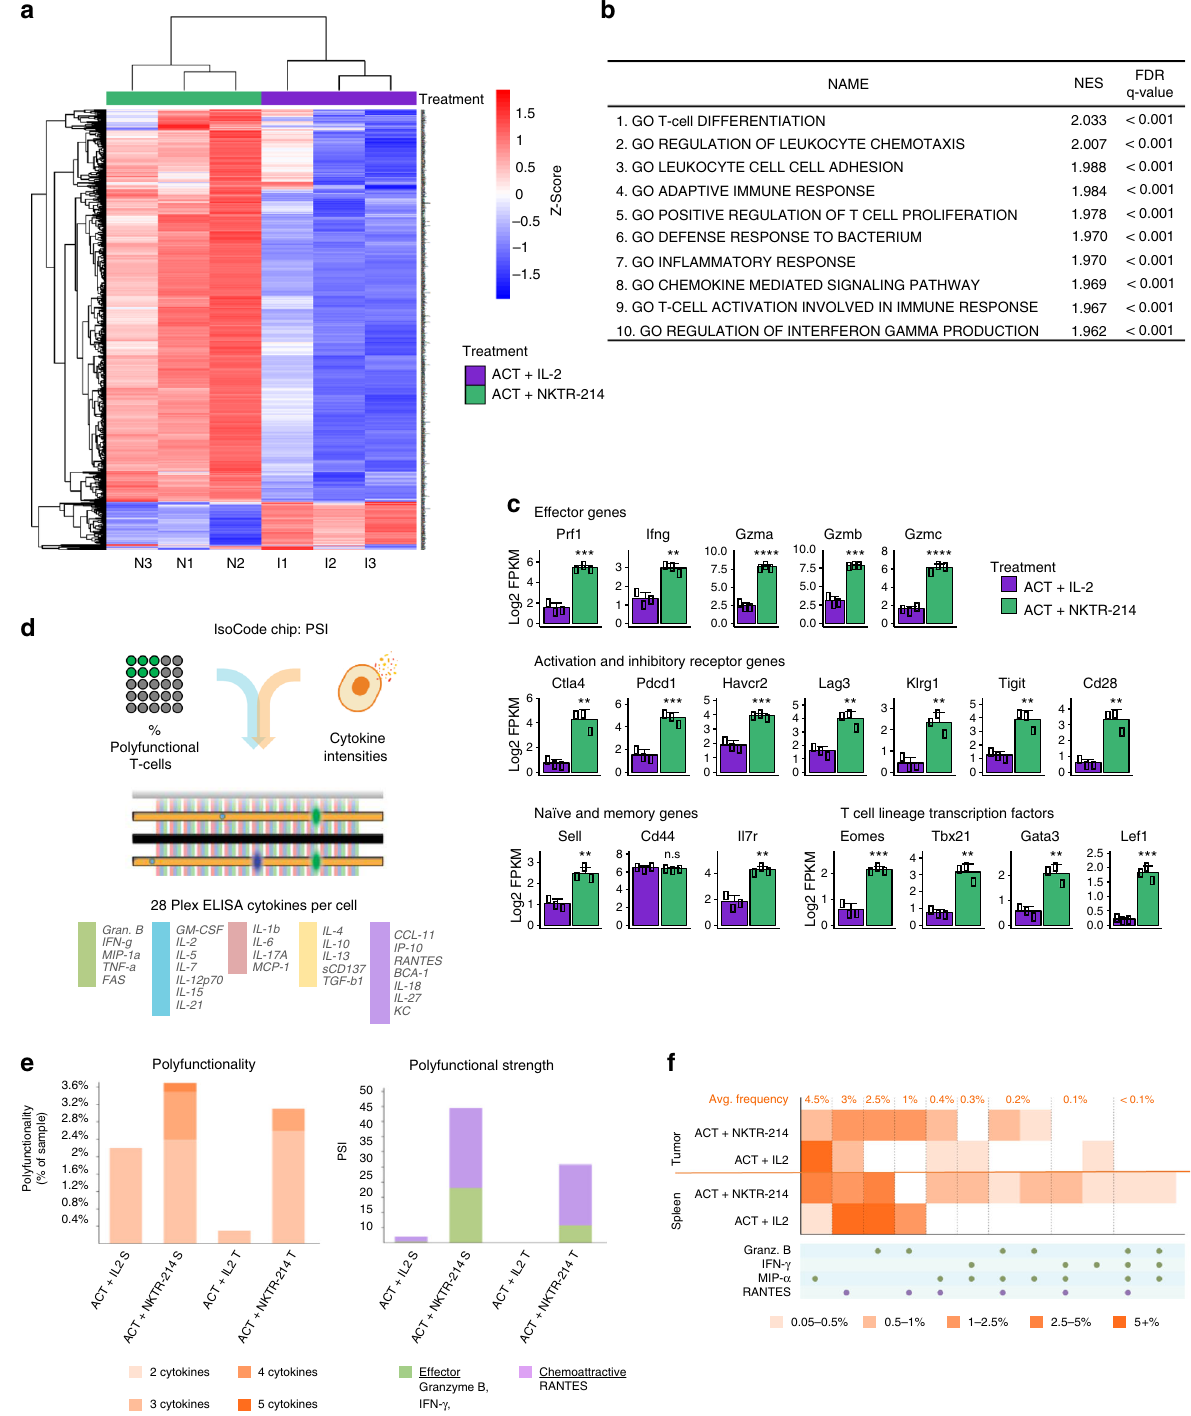
(NCT02869295). Results showed that NKTR-214 induced distinct polyfunctional responses in the cell subsets at days eight of cycle one (C1D8), eight of cycle two (C2D1 and C2D8) and one of cycle three (C3D1), compared to pre-dose (cycle one day one, C1D1). NKTR-214 upregulated the PSI of NK cells in blood samples from all the patients after one course of treatment, with a higher increase after the second dose of NKTR-214 (Fig. 6).